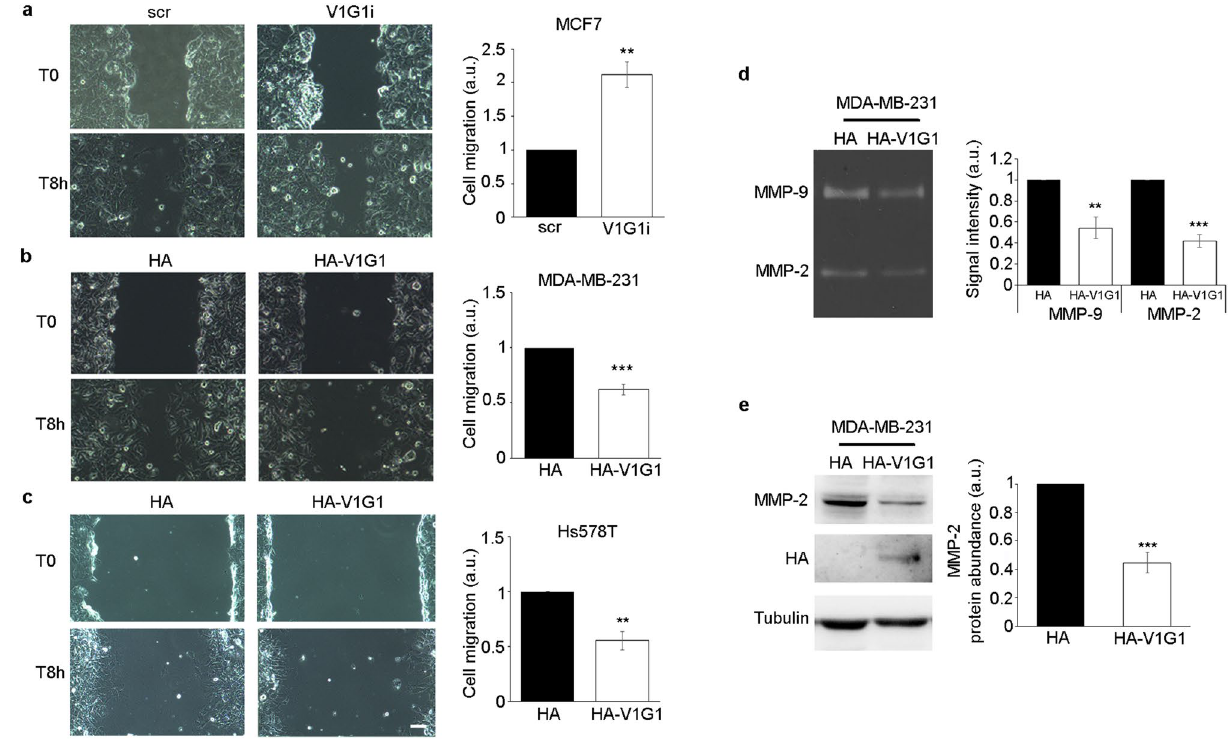
Figure 2. V1G1 modulates invasive phenotype of breast cancer cells. V1G1-depleted MCF7 (V1G1i) ( a ) and HA-V1G1 overexpressing MDA-MB-231 ( b ) or Hs578T cells ( c ) were imaged during wound healing assay at initial time point (T0) and 8 h after the scratch. Cell migration was measured as the ratio between the closed area of the wound in control cells (HA or scr) and HA-V1G1 overexpressing or V1G1 silenced cells. Scale bar = 100 µm. ( d ) Gelatin zymography was performed using conditioned medium of MDA-MB-231 cells overexpressing HA-V1G1 and control. Representative results are shown. ( e ) Western blot analysis was performed using specific anti-MMP-2, anti-HA and anti-tubulin antibodies. Intensity of bands was measured using the software Image Lab. Data represent the mean ± s.e.m. of at least three experiments. Statistical analysis was performed using Student’s t-test with control cells (scr or HA) as referring sample set to 1. ** p ≤ 0.01; *** p ≤